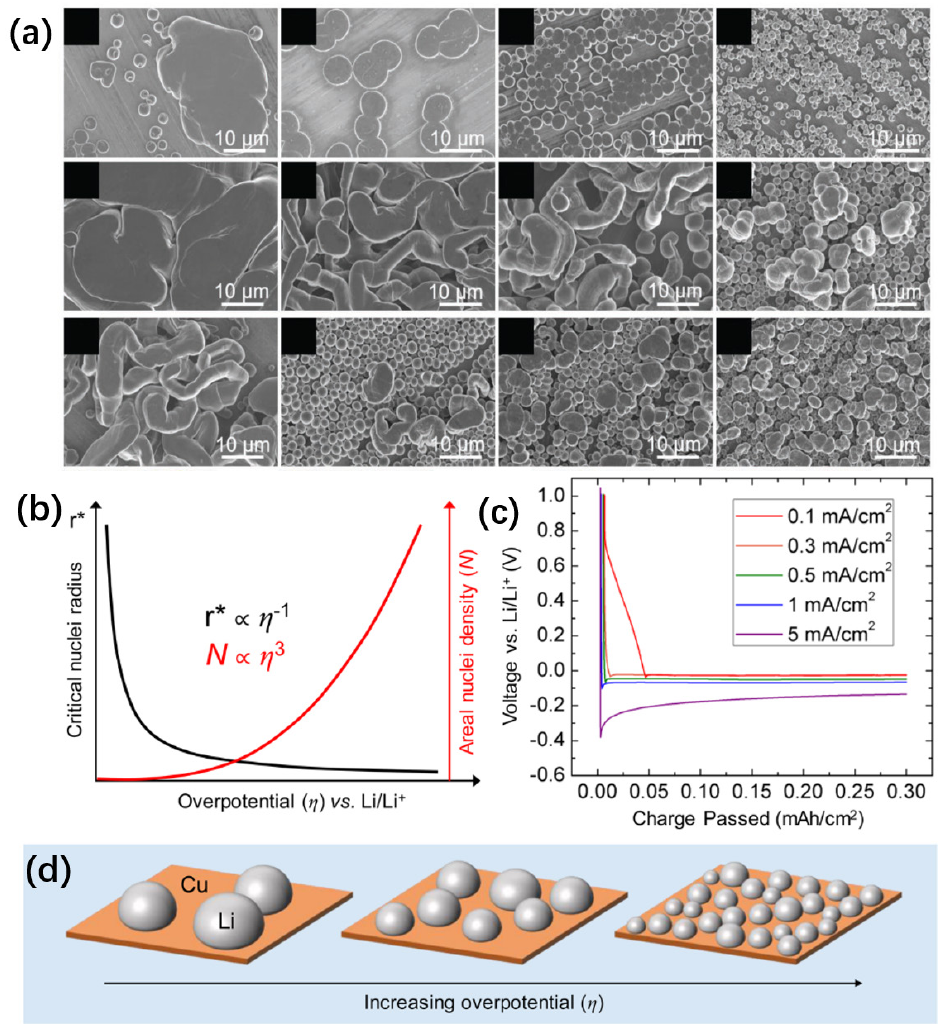
Figure 3. ( a ) Nucleation states of Li metal on copper substrates at different temperatures and current densities [39]. ( b ) Schematic diagram of the relationship between critical Li core radius and areal core density and Li deposition overpotential. ( c ) Experimental voltage distributions of Li deposition on Cu at different current densities. ( d ) Schematic illustration of the size and density of Li nuclei deposited on Cu at different overpotentials [53].